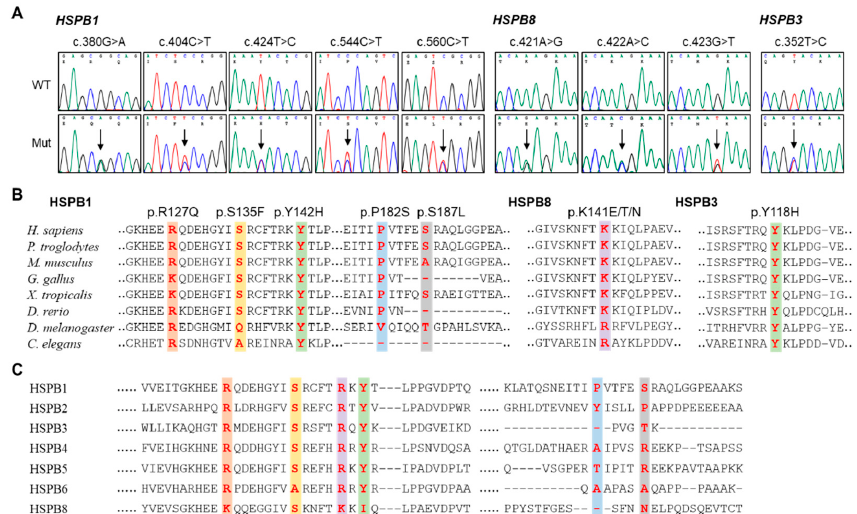
Figure 1. Inherited peripheral neuropathy families with small heat shock protein gene mutations. Genotypes of the inter- ested variants are provided at the bottom of all examined family members. Arrows indicate the proband (unfilled symbols ( □ , ○ ): unaffected individuals; black-filled symbols ( ■ , ● ): affected individuals; gray-filled symbols: unaffected individuals having corresponding mutation; ˄ : twins). ( A ) Pedigrees with HSPB1 mutations. ( B ) Pedigrees with HSPB8 mutations. ( C ) Pedigree with HSPB3 mutation.